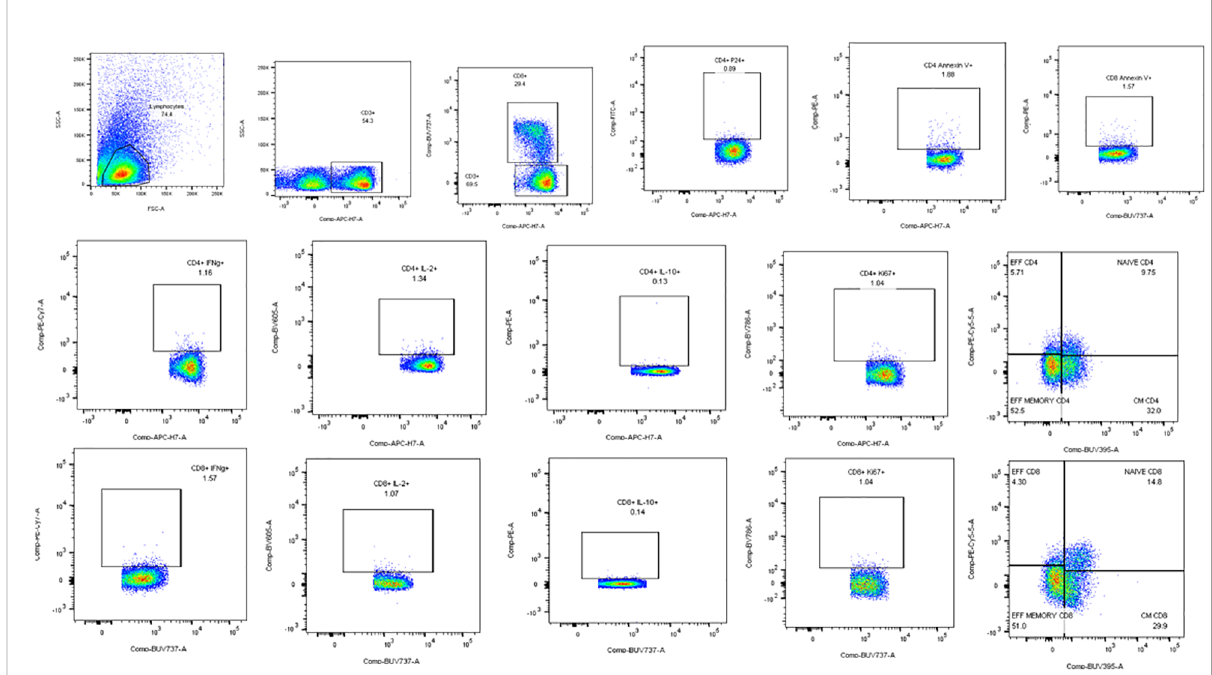
FIGURE 3 Representative fl ow cytometry plots showing the gating strategy used for the analysis of the fl ow assays. Lymphocytes identi fi ed by forward and side scatter were further gated for the identi fi cation of CD3, CD4, and CD8 T cells. All the other markers were plotted on CD4 and CD8 cells as shown in the